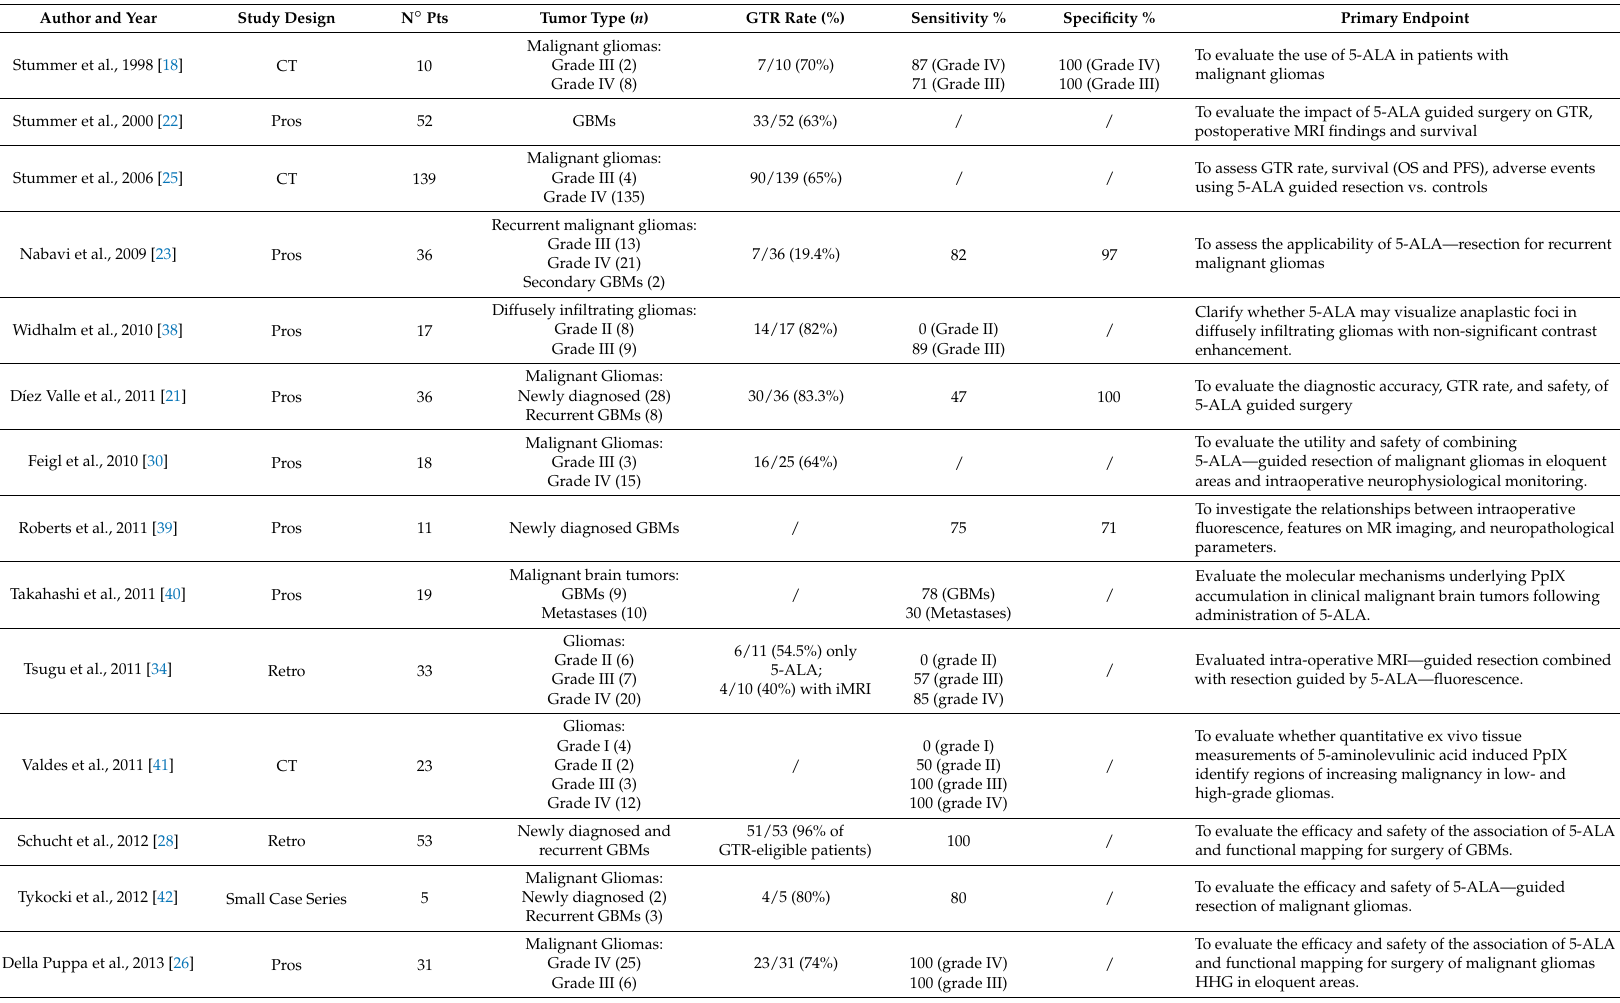
Table 1. Clinical series of patients with gliomas treated with a 5-amino-levulinic acid aided surgery. Literature